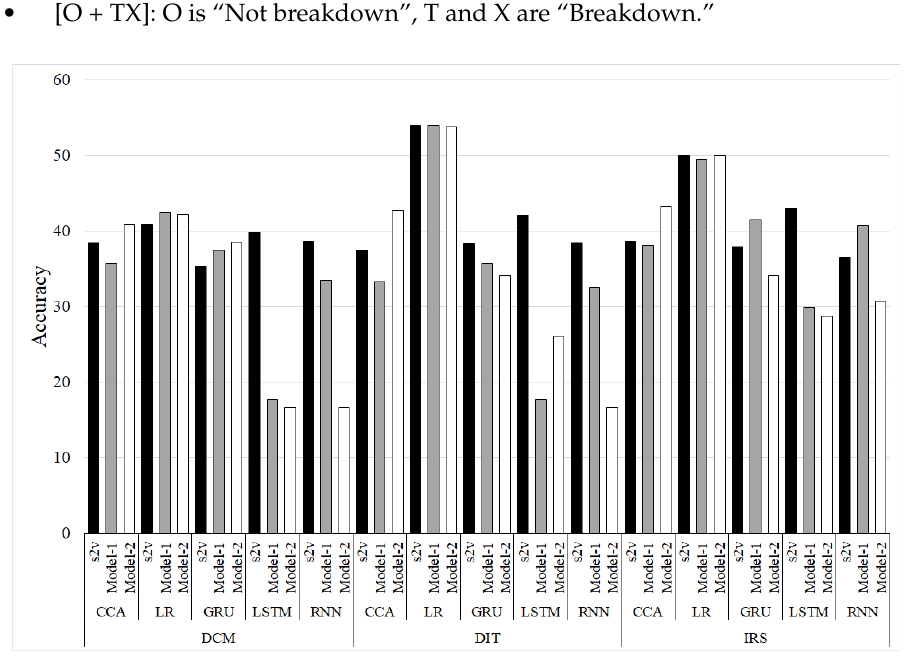
Figure 9 . Experimental results (Accuracy). Figure 9. Experimental results (Accuracy).